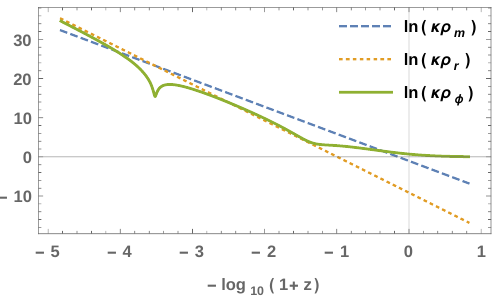
Figure 1. The evolution of the energy densities for the tripod models. Figure from